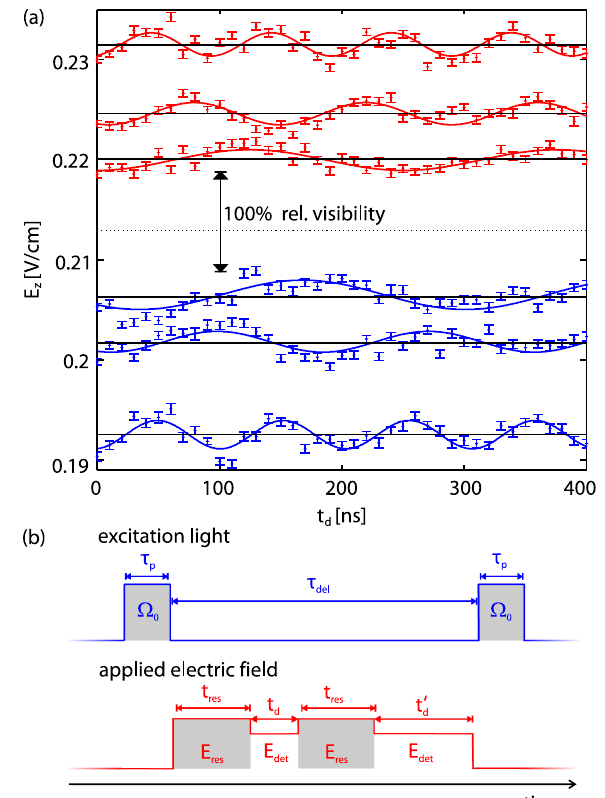
FIG. 3. (a) Oscillations in the visibility are measured for (b) the pulse sequence of the double-Ramsey experiment. The electric field during the delay time E det is indicated by the solid horizontal black lines in (a). The oscillations in the visibility (data points with error bars resulting from the standard deviation of the fit to the Ramsey spectrum) are centered around the applied electric field. The solid curves are sinusoidal fits to the data. Blue data (lower three measurements) and red data (upper three measurements) indicate positive and negative Fo¨rster de- fects, respectively. The dotted line indicates the position of the Fo¨rster